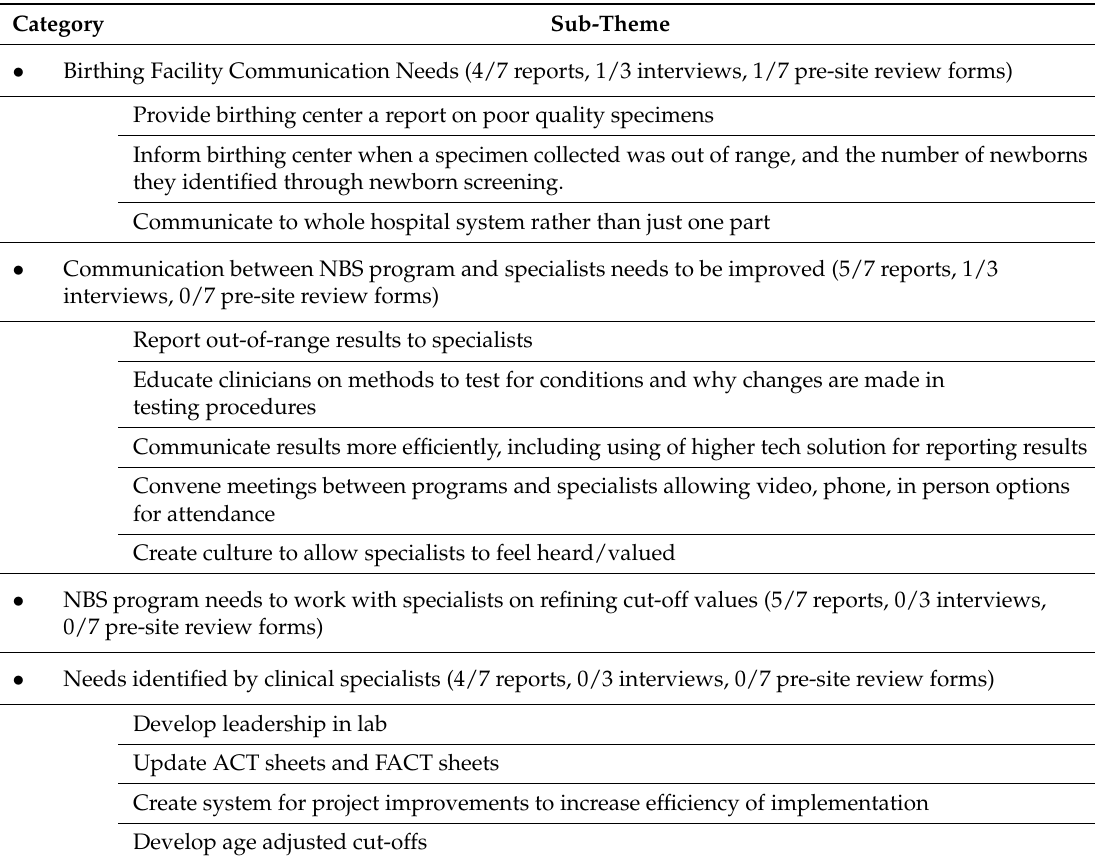
Table 2. Needs identified in State Newborn Screening Program Site Reviews: Communication Outside the State Newborn Screening Program themes identified (Number of times reported in site review report, individual interview, and pre-site review